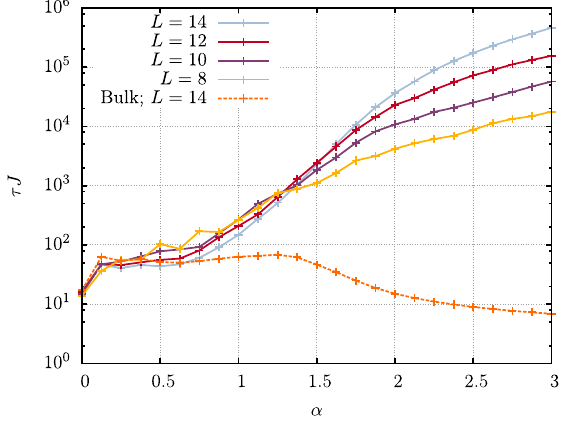
FIG. 5. The decay time (on a logarithmic scale) of a MZM in the transverse-field Ising model with long-ranged interactions at T ¼ ∞ for L ¼ 8 – 14 sites and h ¼ 0 . 2 , as obtained by exact diagonalization. It is plotted as a function of α , the power of the decay of the long-ranged interaction. As in Fig. 2, the decay time saturates in L for larger values of the perturbing couplings. The decay times for ferromagnetic and antiferromagnetic interactions are the same at T ¼ ∞ ; it is only at lower temperatures where the effect of the long-ranged order for α < 2 in the ferromagnetic case becomes